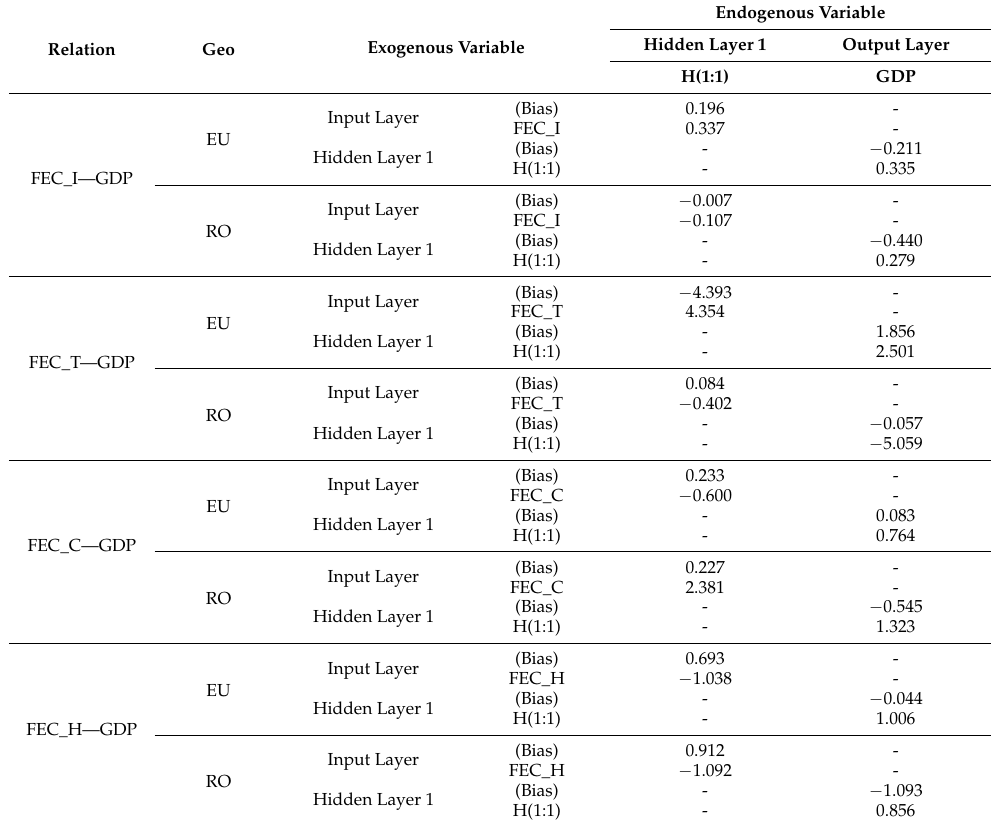
Table A5. Estimation of MLP network parameters regarding final energy consumption by sector and economic